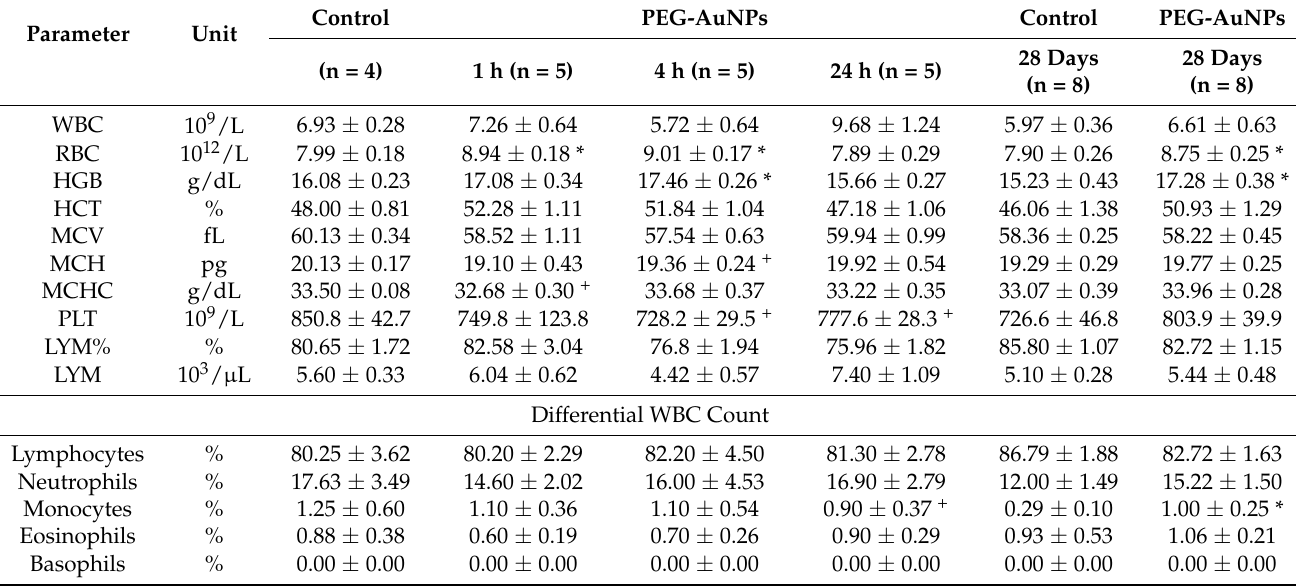
Table 7. Hematological parameters in rats at 1 h, 4 h, 24 h, and 28 days post-injection of